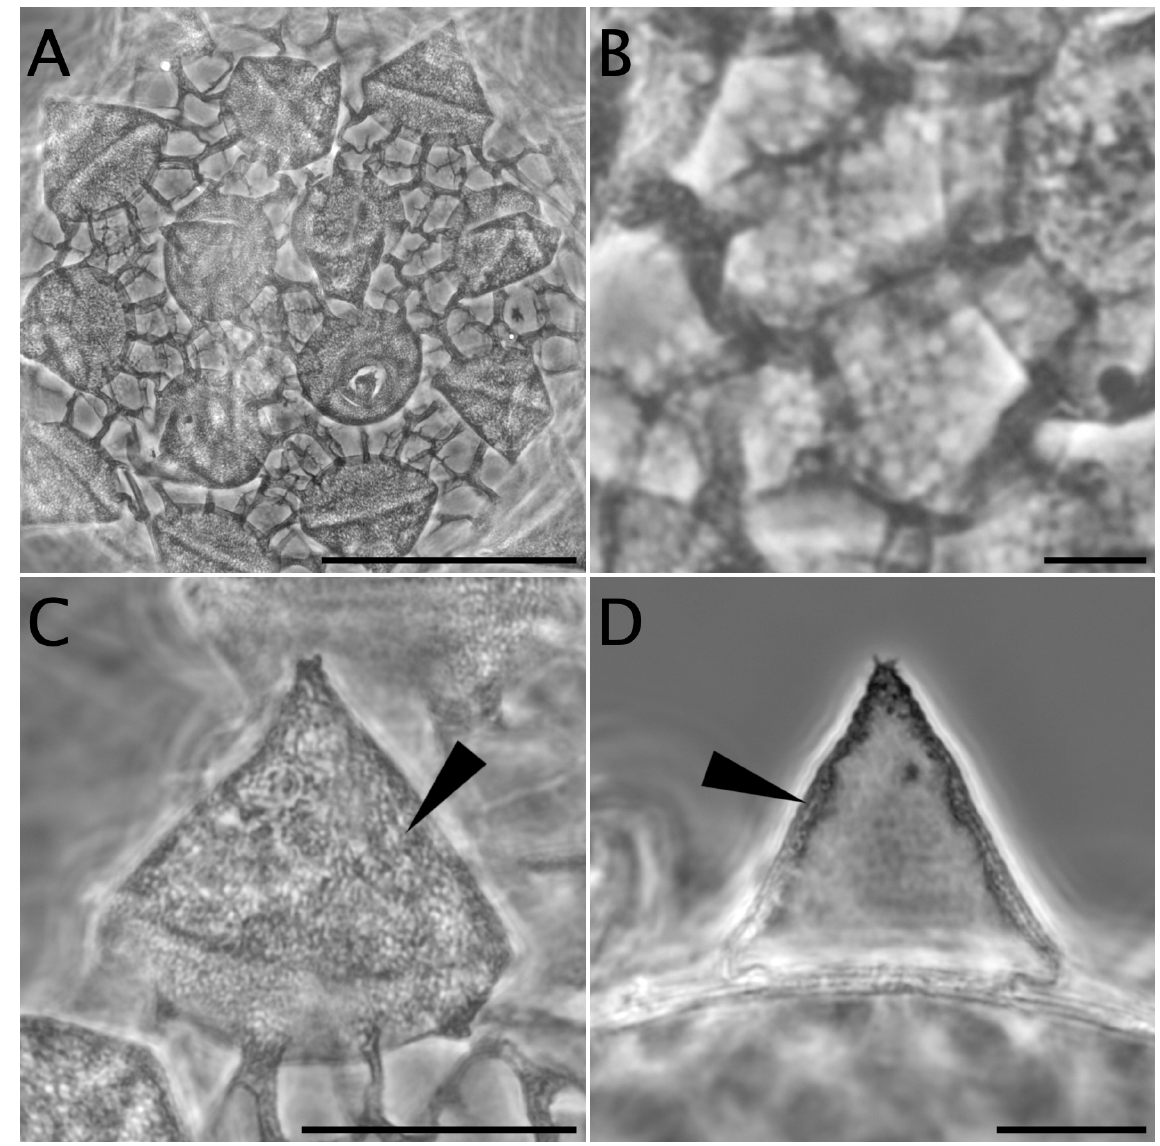
Fig. 5. Sisubiotus hakaiensis sp. nov. Paratype (JYUt.S418_SL1_A). Eggs in PCM. A . Egg surface. B . Reticulated chorion between areolations. C . Egg process with labyrinthine layer (arrowhead); seen as reticulation. D . Egg process in section showing labyrinthine layer (arrowhead). Scale bars: A = 50 μm; B = 5 μm; C = 20 μm; D = 10